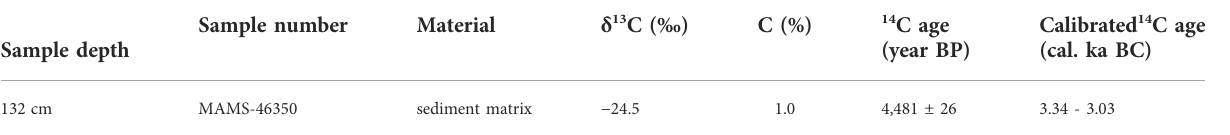
FIGURE 6 Analytical results of the trench.